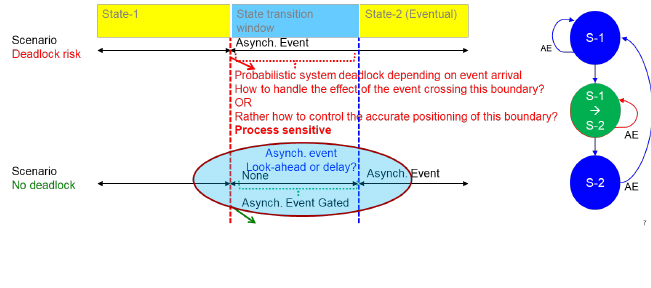
Figure 4. Asynchronous event look ahead